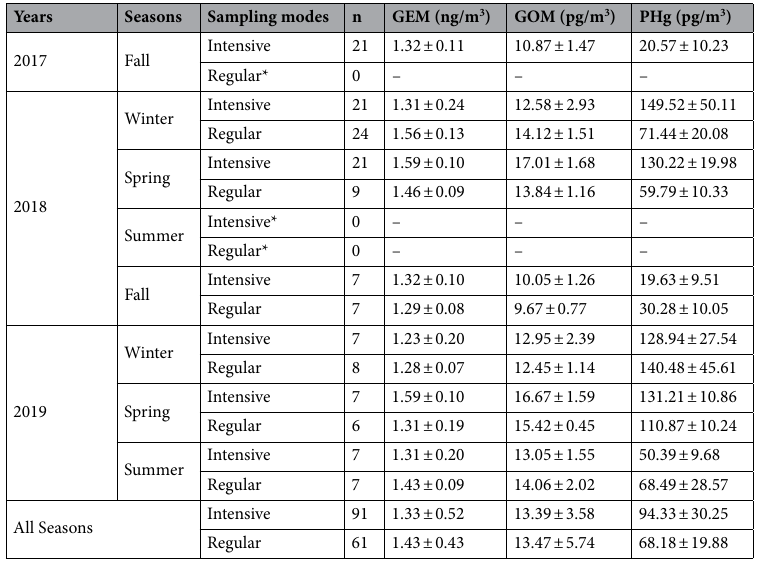
Table 1. Comparison between intensive and regular samplings of atmospheric speciated mercury at the Taiping Island in South China Sea. GEM gaseous elemental mercury, GOM gaseous oxidized mercury,